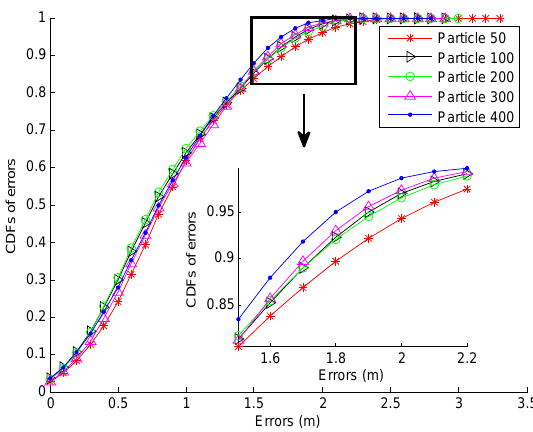
Figure 26. CDFs of errors under different numbers of particles.